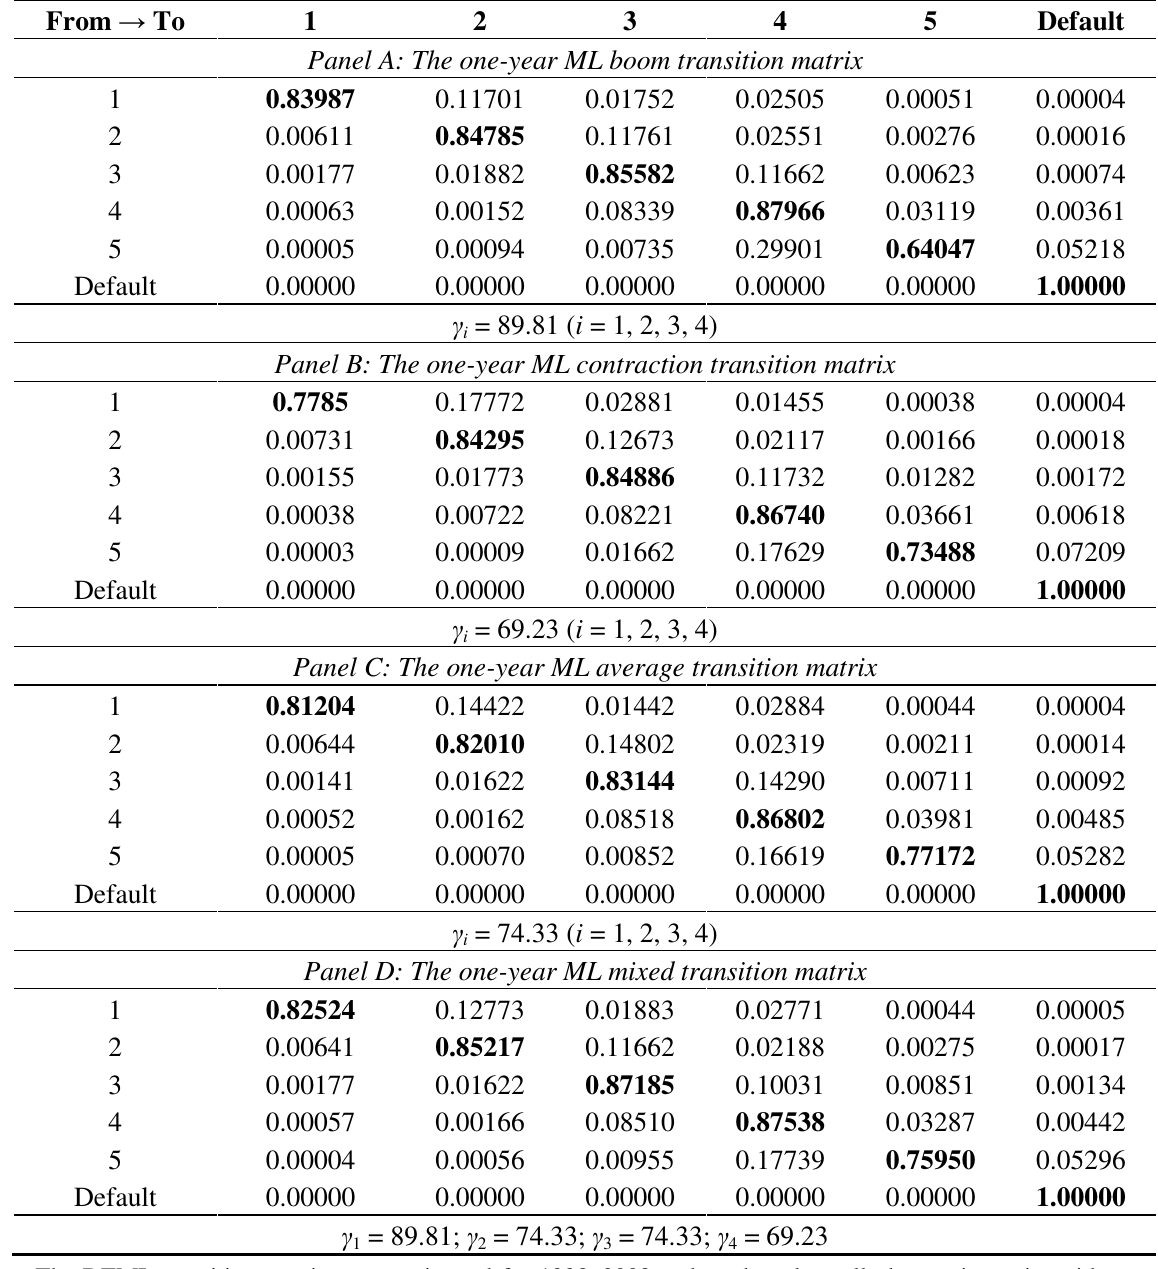
Table 4. Transition probabilities in time-dependence: DTML results on different business cycle